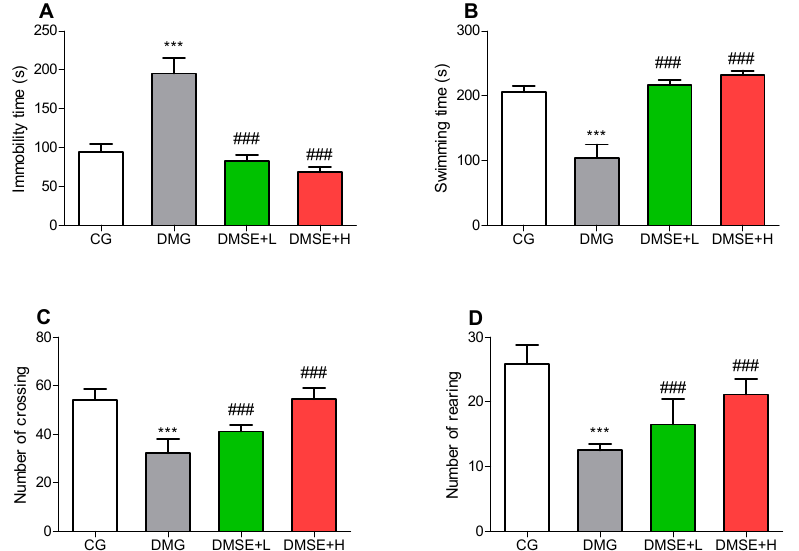
Figure 2. Effect of MSE on ( A ) immobility, ( B ) swimming time in the forced swimming test, ( C ) number of crossing and ( D ) number of rearing in the open field test in diabetic rats. Data represent mean ± SD. *** p < 0.05 when compared to the control group. ### p < 0.05 when compared to the diabetic group.